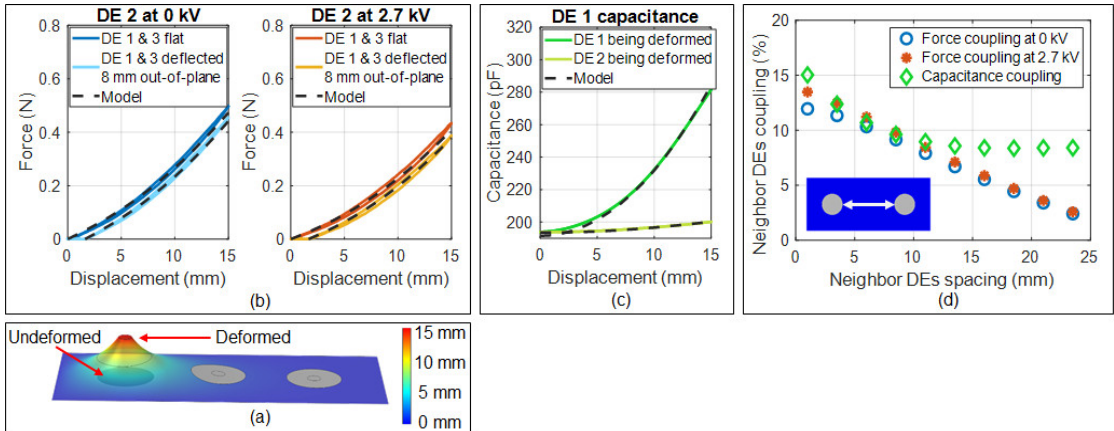
Figure 5. 3 × 1 DEA system, FE mesh ( a ), electro-mechanical simulation of 3 × 1 DEA system, exper- imental validation actuation ( b ), electro-mechanical simulation of 3 × 1 DEA system, experimental validation sensing ( c ), electro-mechanical coupling effects ( d ).